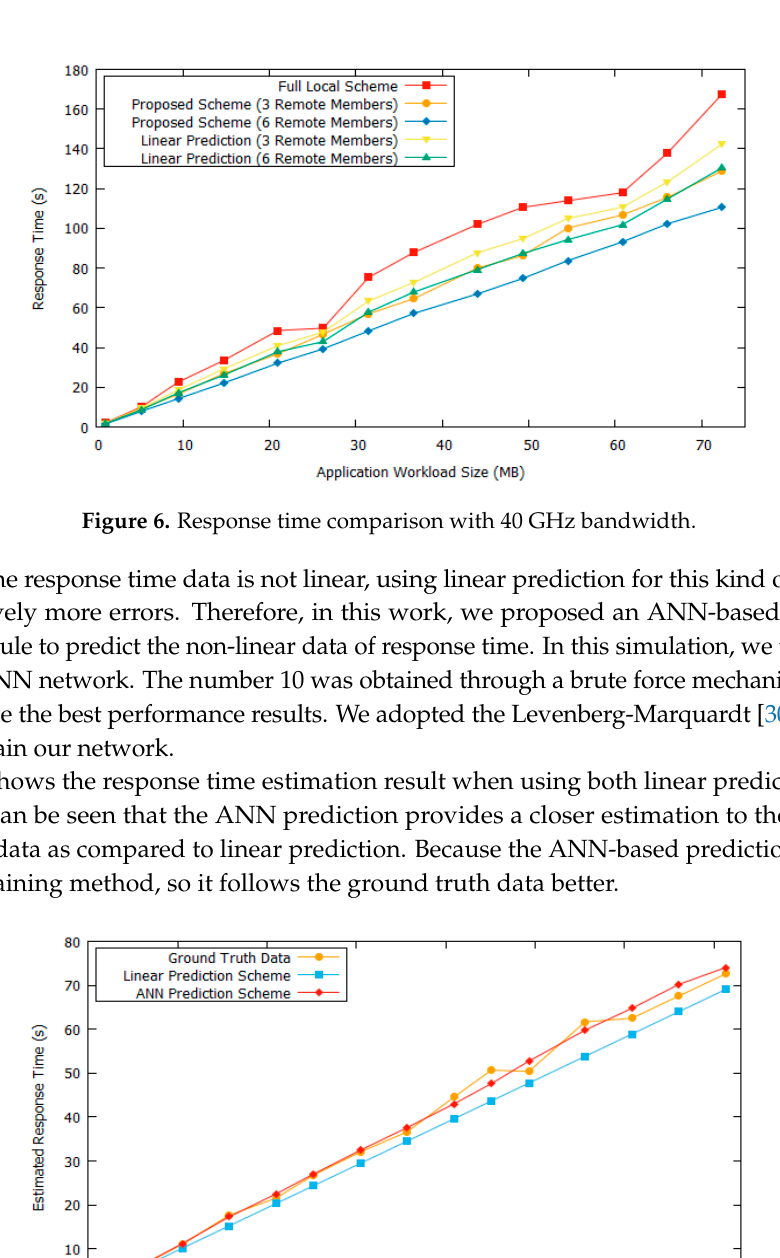
Figure 7. Response time estimation result comparison.